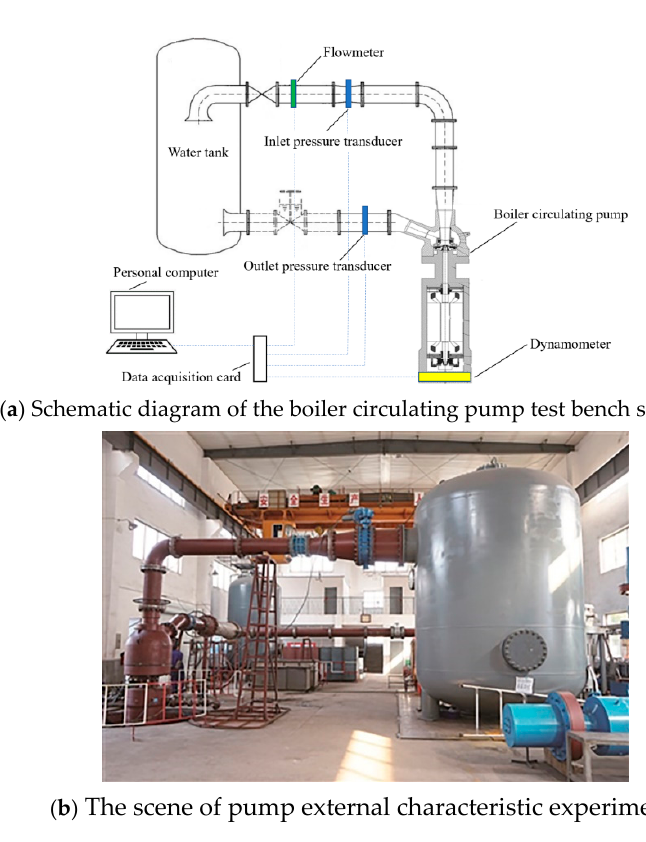
Figure 5. Test bench of boiler circulating pump.